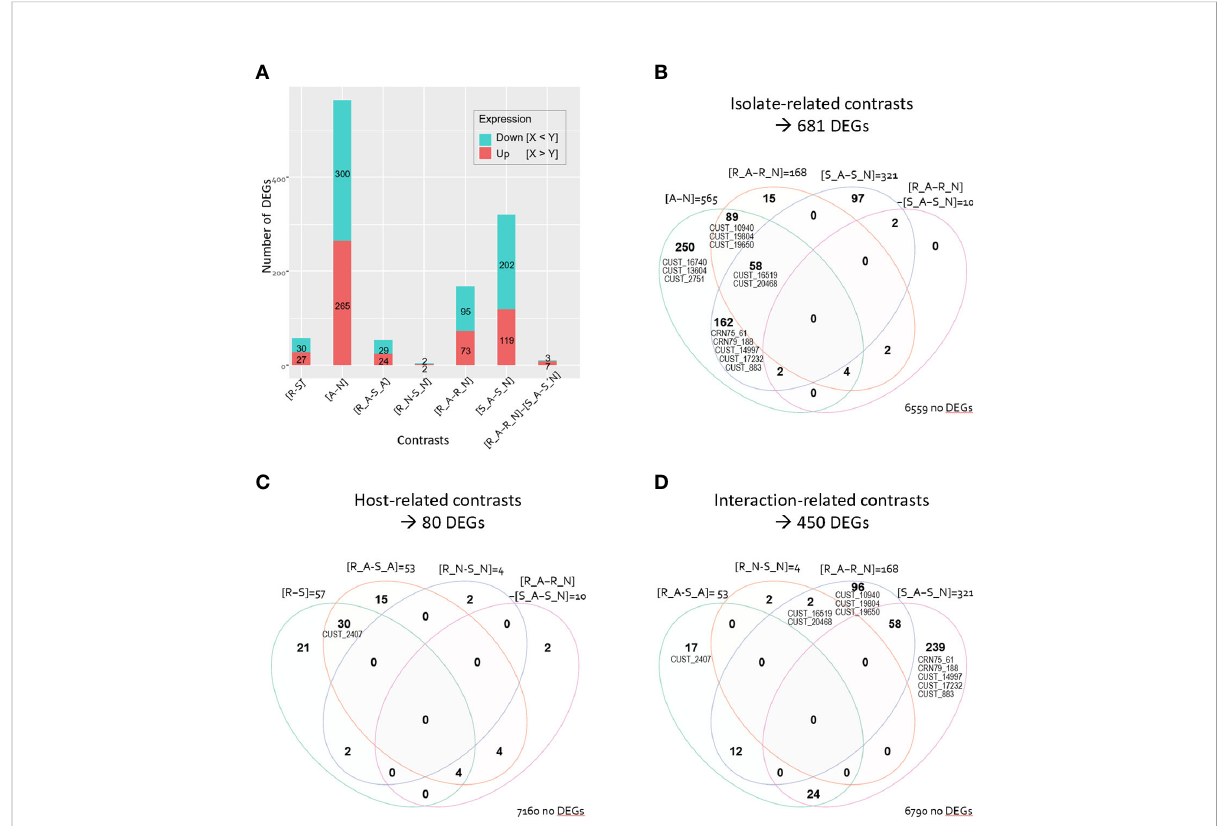
FIGURE 2 Number of differentially expressed Phytophthora capsici genes (DEGs). (A) Barplot of number of up- and down-regulated DEGs for the seven contrasts. Venn diagram illustrating the DEG repartition depending on (B) the isolate-related contrasts, (C) the host-related contrasts, and (D) the host-isolate interaction-related contrasts. Venn diagram indicates numbers of DEGs that are common to several contrasts and numbers that are unique to a single contrast. Numbers of genes that are not differentially expressed in the considered contrasts are indicated at the right bottom of each Venn diagram. The CRNs and RxLRs (CUST) are positioned on each Venn diagram in their respective